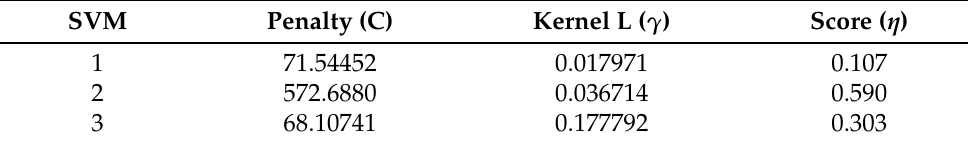
Table 3. Hyperparameters and relative scores for a pool of SVM